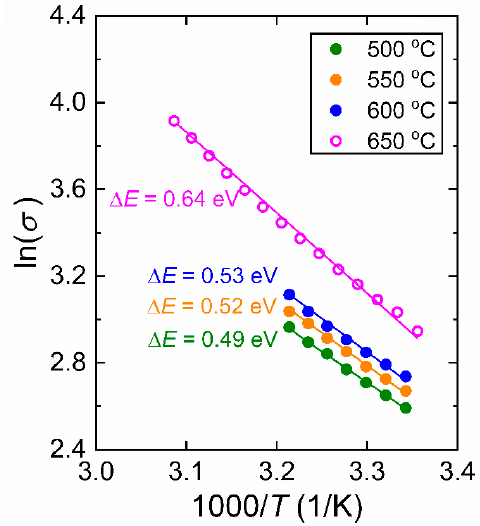
Figure 12. Arrhenius plot of conductivity ( σ ) data obtained from VO 2 films in their insulating phases. Data set for VO 2 film prepared at 650 °C is extracted from the σ vs. T plot in Ref. [32].